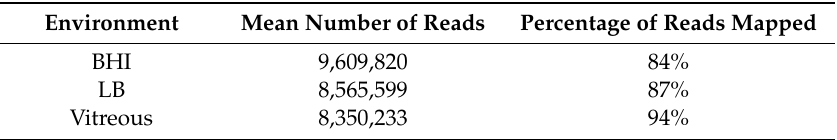
Table 2. Mean number of reads and percentage of reads that mapped to the B. cereus ATCC 14,579 genome for each environmental condition.